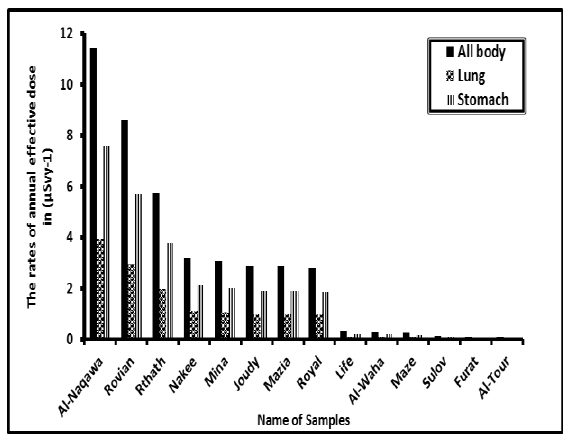
Fig.3: The rates of annual effective dose of radon concentration in healthy drinking water samples .